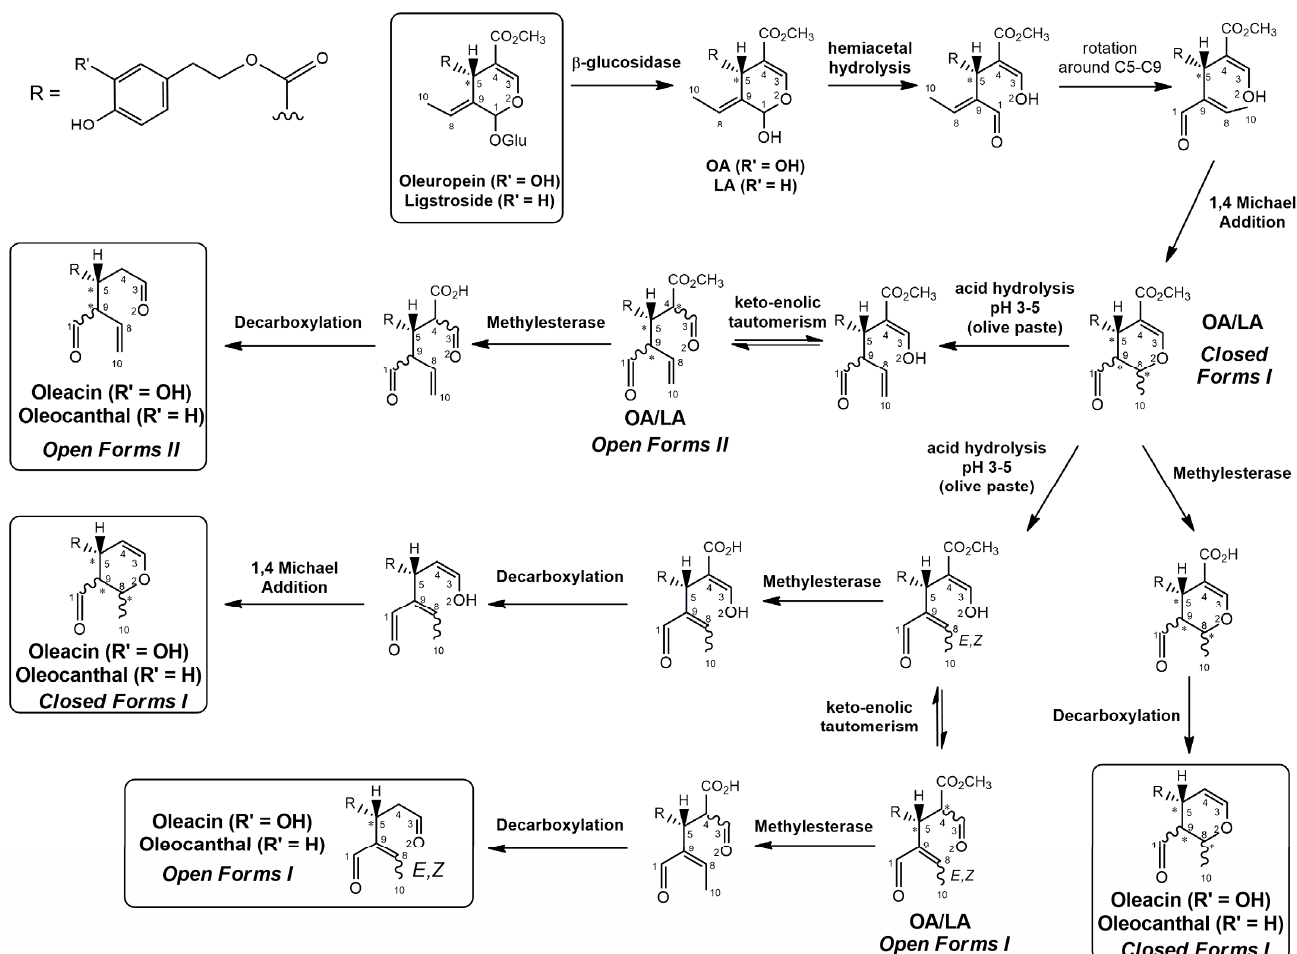
Figure 1. Schematic representation of the complex sequence of enzymatic and chemical processes occurring during olive oil production, leading from the main secoiridoids contained in olive drupes, oleuropein and ligstroside, to oleuropein and ligstroside aglycones (OA/LA) and finally to oleocanthal and oleacin, whose main isoforms are shown. See text for details. The chiral center on C5 and the stereogenic center on C9 are marked by an asterisk.